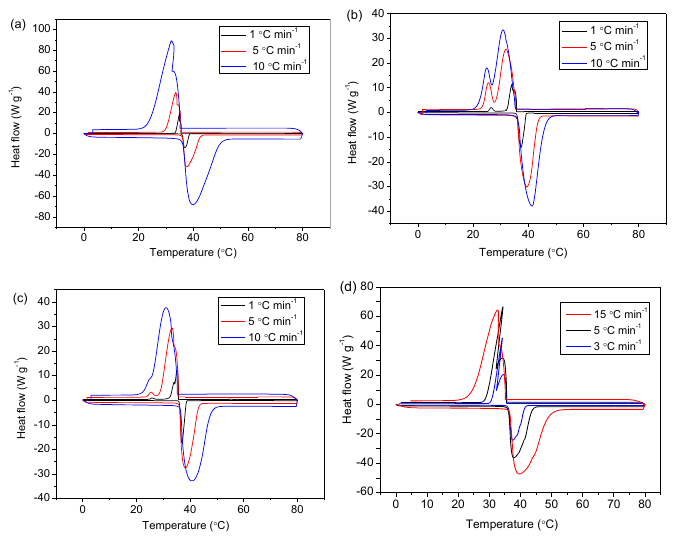
Figure 6. DSC curves of n -eicosane-encapsulated capsules with different sizes: ( a ) ~150 µm, ( b ) ~50 µm, and ( c ) ~20 µm. The heating – cooling rates vary at 1, 5, and 10 °C·min − 1 . ( d ) DSC curves of bulk n - eicosane chemical without encapsulation, with heating – cooling rates of 3, 5, and 15 °C·min − 1 . From the DSC results shown above, we propose two potential mechanisms responsible for the phase-change behaviors of microcapsules under different thermal conditions. First, during the cooling process, the different nucleation kinetics of core materials might relate to the capsule size, since the smaller capsules (50 and 20 µm) undergo partially homogeneous nucleation rather than total heterogeneous nucleation of larger capsules (150 µm). Second, the different degrees of impurities inside microcapsules could be a reason for whether homogeneous or heterogeneous nucleation dominates. The impurities inside the capsules provide nucleation seeds to stimulate heterogeneous nucleation, which initiates at a higher temperature compared to homogeneous nucleation. In contrast, capsules encapsulated with a highly pure core material will lead to a homogeneous nucleation-dominated crystallization, showing a large under-cooling temperature range since the melting point of the core material remains at the same temperature.